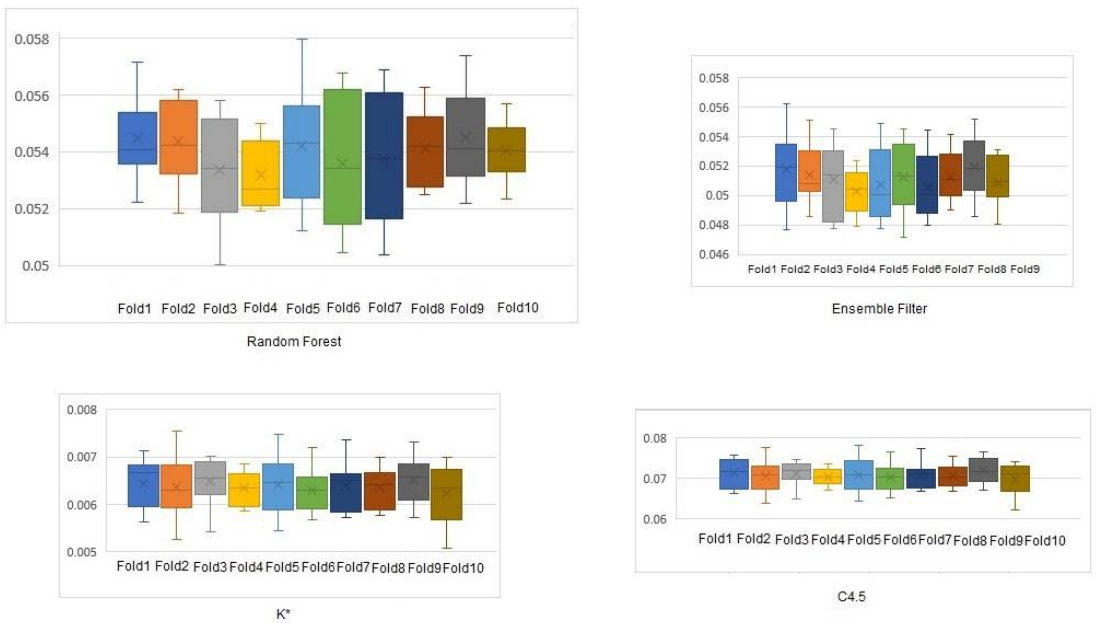
Figure 9. Root mean squared error of the ensemble method and the three classifiers.